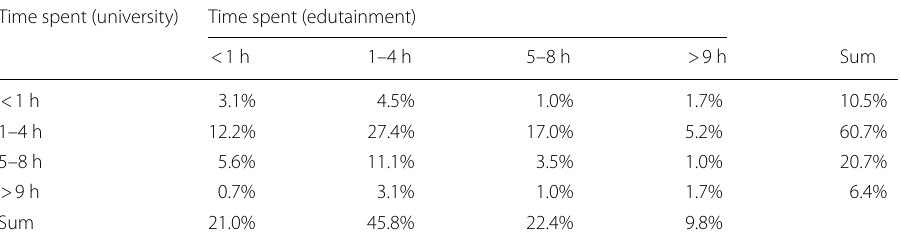
Table 1 Percentage of students using the internet for the specified time brackets for each purpose (school or edutainment) per day